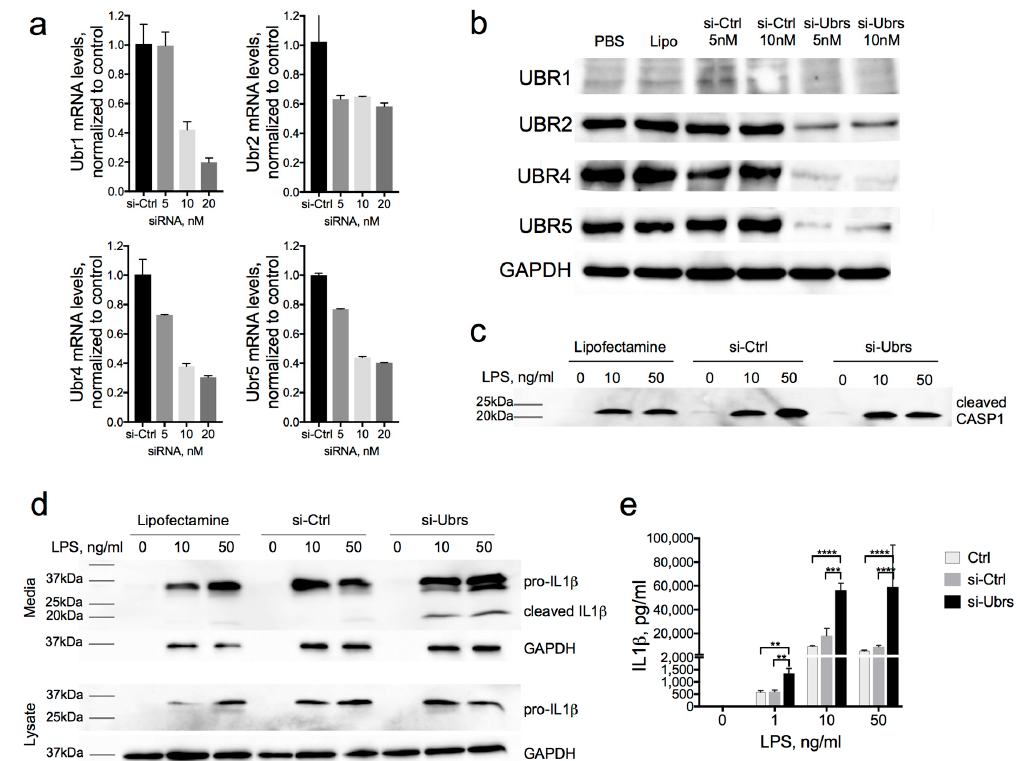
Figure 4. Increased IL1 β secretion after the downregulation of Ubr-ubiquitin ligases of the Arg/N-degron pathway. ( a ) mRNA and ( b ) protein levels of UBR1, UBR2, UBR4, and UBR5 in J774A.1 cells